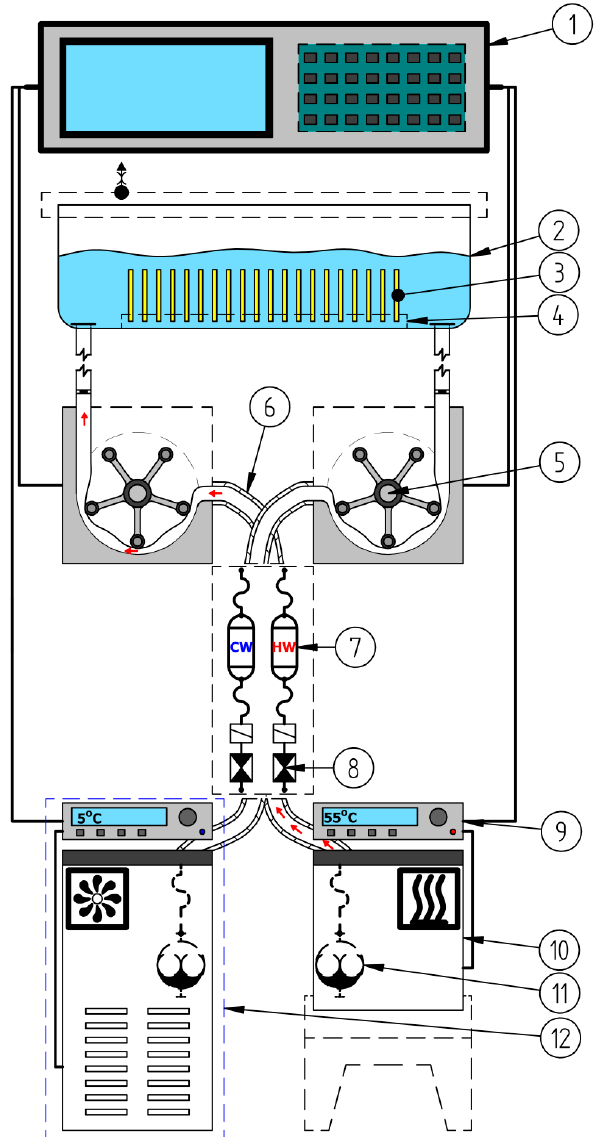
Figure 1. Operation diagram of the device in the pumping phase of heated liquid: 1—digital control system; 2—working vessel; 3—samples on fatigue process; 4—perforated support plate; 5—peristaltic pump; 6—flexible hose insulation; 7—hot water reservoir; 8—electrovalve; 9—thermostat; 10—container with heated liquid; 11—rotary pump; 12—liquid cooling system.